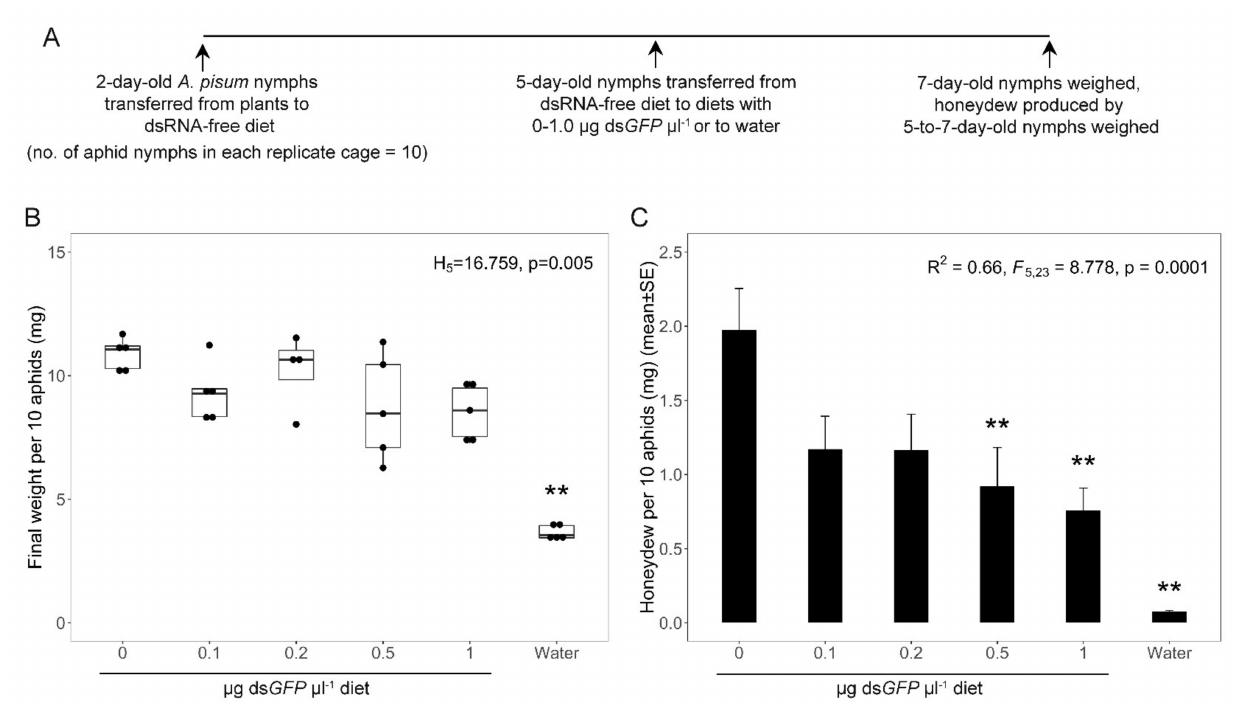
Figure 1. Response of A. pisum CWR09/18 to dietary ds GFP , administered to five replicate groups of ten 5-day-old nymphs for two days. ( A ) Experimental design. ( B ) Total weight of the ten 7-day-old nymphs per cage. ( C ) Honeydew production by the ten aphids per cage over the two-day experiment. Double asterisks identify treatments are significantly different from ds GFP -free diet at α = 0.01. Five replicate cages were assayed for all treatments, except 0.2 µ g µ L − 1 , with four replicate